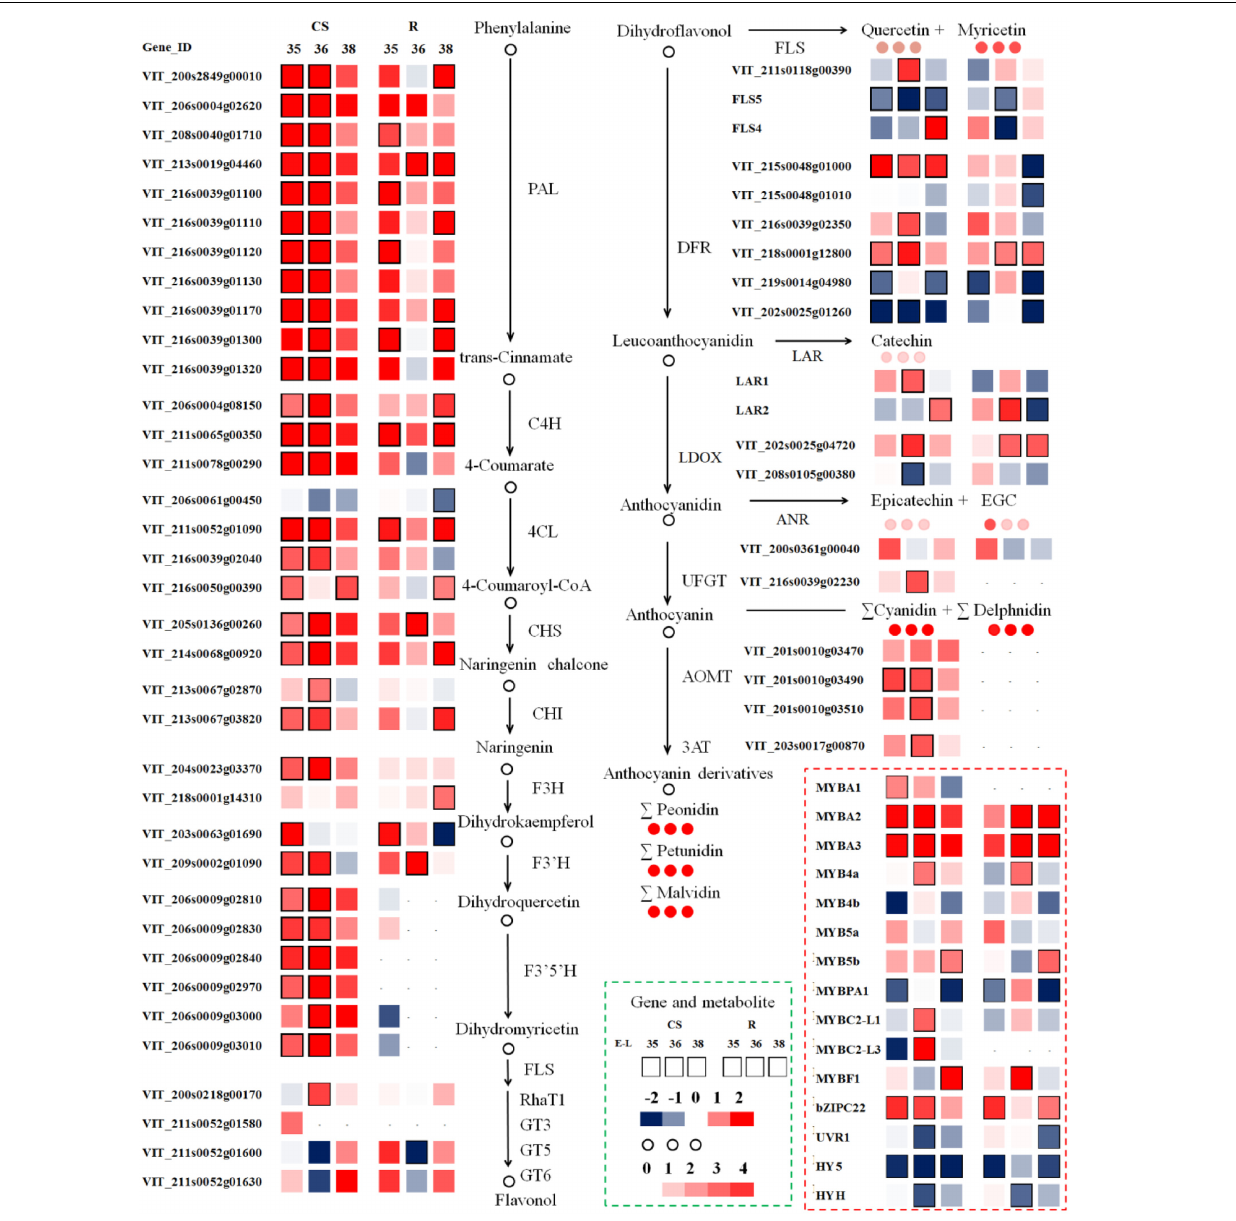
FIGURE 6 | Modulation in berry transcripts involved in the phenylpropanoid and flavonoid pathway in summer and winter berries in 2014. Blue and red boxes indicate downregulated and upregulated transcripts, respectively, in winter berries versus large berries. Boxes with bold margins indicate differential expressed genes between two cropping cycles at a given developmental stage. Circles represent metabolites and their colors represent the fold changes in metabolite in “CS” at a given ripening stage when comparing winter berries versus control summer berries. TFs (lower right corner) involved in the regulation of the phenylpropanoid and the flavonoid pathway transcripts are depicted in dotted red rectangle. The complete data set can be accessed in Supplementary Table